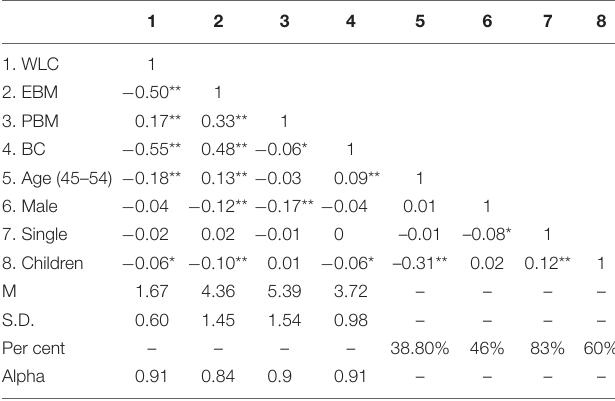
TABLE 1 | Bivariate correlations, means, standard deviations, percentages, and alpha reliabilities for all study